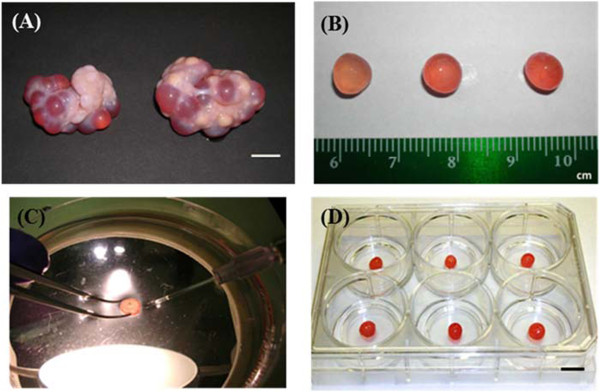
Porcine ovaries, dissected antral follicles and DNA lipid complex microinjection of ovarian antral follicles. A pair of porcine ovaries in follicular phase of the estrous cycle (A); dissected porcine antral follicles between 6.5 to 7.5 mm in diameter (B); DNA lipid complex microinjection into an antral follicle size between 6.5 to 7.5 mm in diameter on 100 × 15 mm sterile polystyrene disposable petri dish containing approximately 20 ml of CO2 Independent Medium using the Eppendorf FemtoJet® microinjector under a standard dissecting microscope (C); and representative in vitro antral follicle culture condition on the membrane of Millicell-CM culture plate insert in the 6-well plate with Opti-MEM®-I reduced serum medium (D). Scale bars (A) and (D) = 1.0 cm.